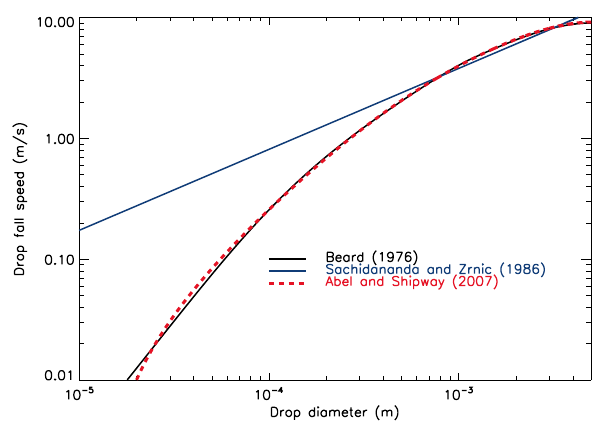
Fig. 1. Raindrop fall speed relations as a function of diameter. The blue line shows the fall speed relation of Sachidananda and Zrni ´ c (1986), which was used in GA2.0 and before. The black line is the observations of Beard (1976) and the red line is the new parametrization of Abel and Shipway